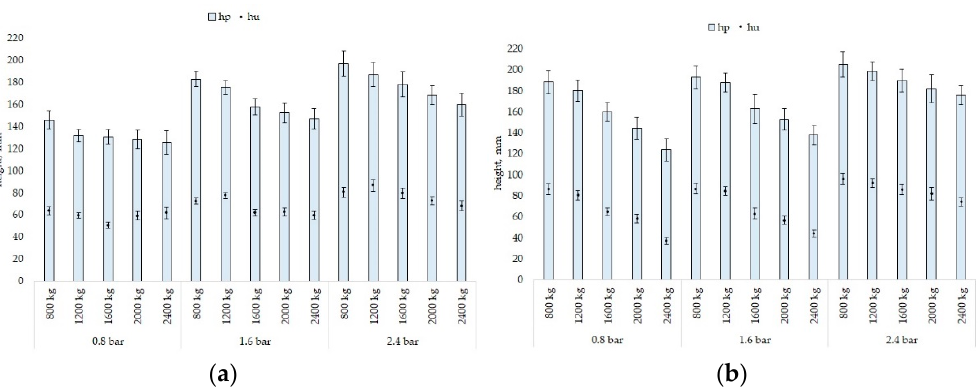
Figure 5. The values of the heights of tire profiles: radial tire ( a ); bias-ply tire ( b ); h p —total height of tire profile, h u —height of maximum deflection of the tire; linear markers mean standard deviation.